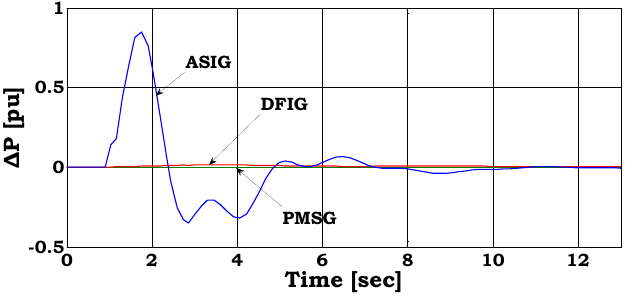
Figure 7. Change in active power production during a frequency drop for three wind turbine